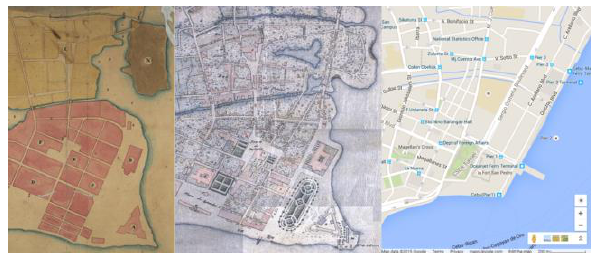
Figure 16. Georeferenced historical maps of Cebu City: Left - 1833 map courtesy of the National Archives of the Philippines, Middle - 1873 map retrieved online, Right - Google Map.